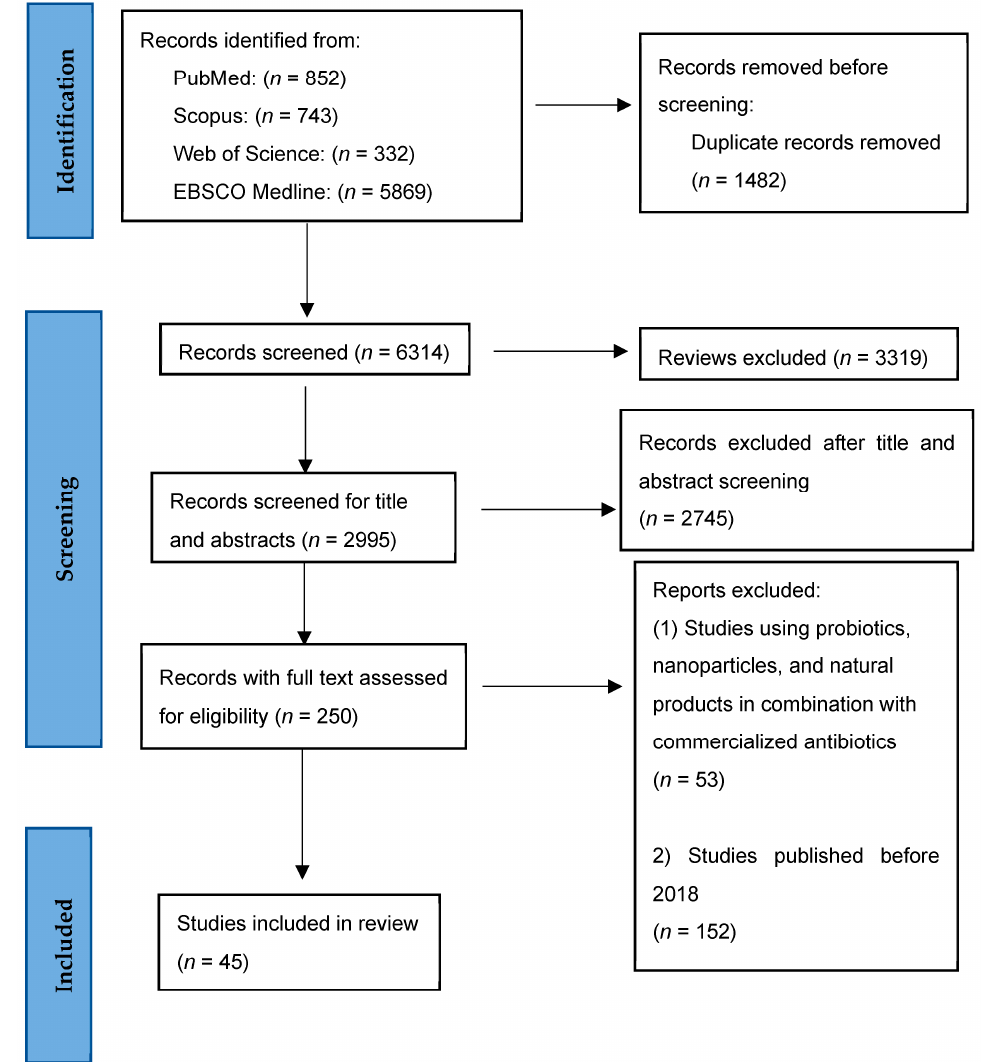
Figure 1. Flow diagram outlining article screening for inclusion in this systematic review using PRISMA guidelines. After screening evaluation, 45 articles were eligible for inclusion in this system- atic review.